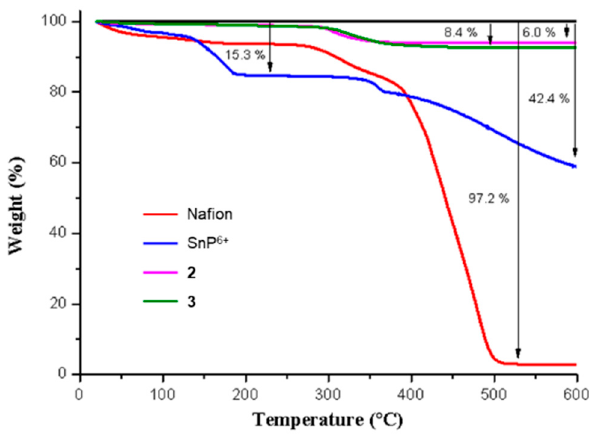
6+ -embedded Nafion/Pt-TiO